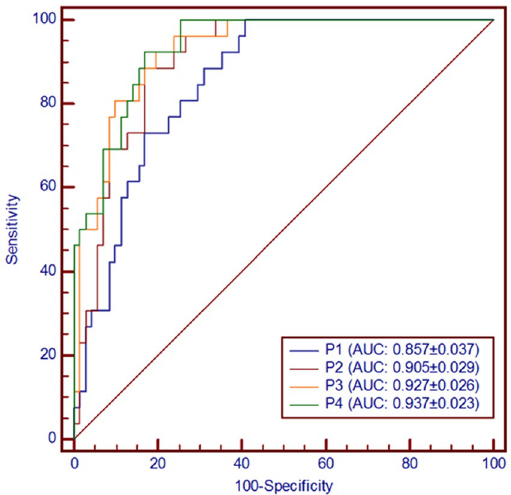
Figure 6. The ROC analysis results from the four diagnostic models calculated from the logistic regression analysis. The performance of each biomarker model was evaluated by the area under the ROC curve (AUC) and the determination of sensitivity and specificity at the optimal cut-off point defined by the minimum distance to the top-left corner. The optimized model was the P4 model with an AUC of 0.937 (95% CI: